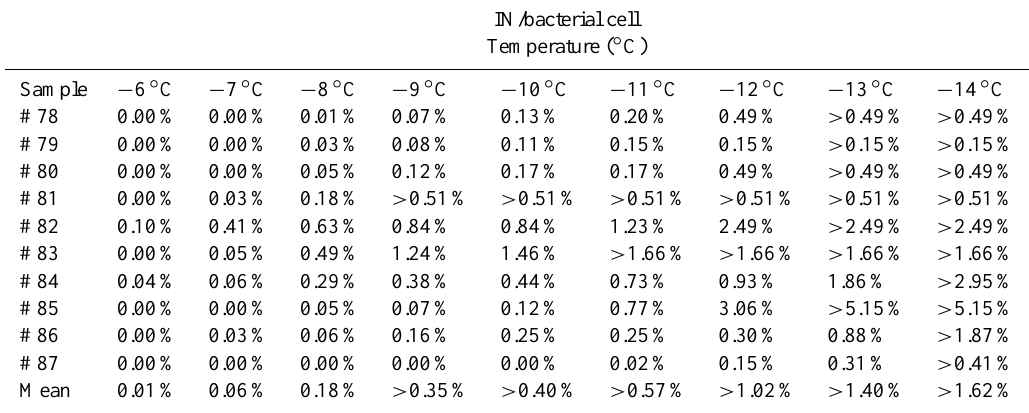
Table 3. Inferred maximum possible fraction of INA bacteria among total bacteria in the samples based on heat-sensitive IN concentrations and on total bacteria counts. A “ > ” indicate values higher than experimental quantification limit for heat-sensitive IN. IN/bacterial cell Temperature ( ◦